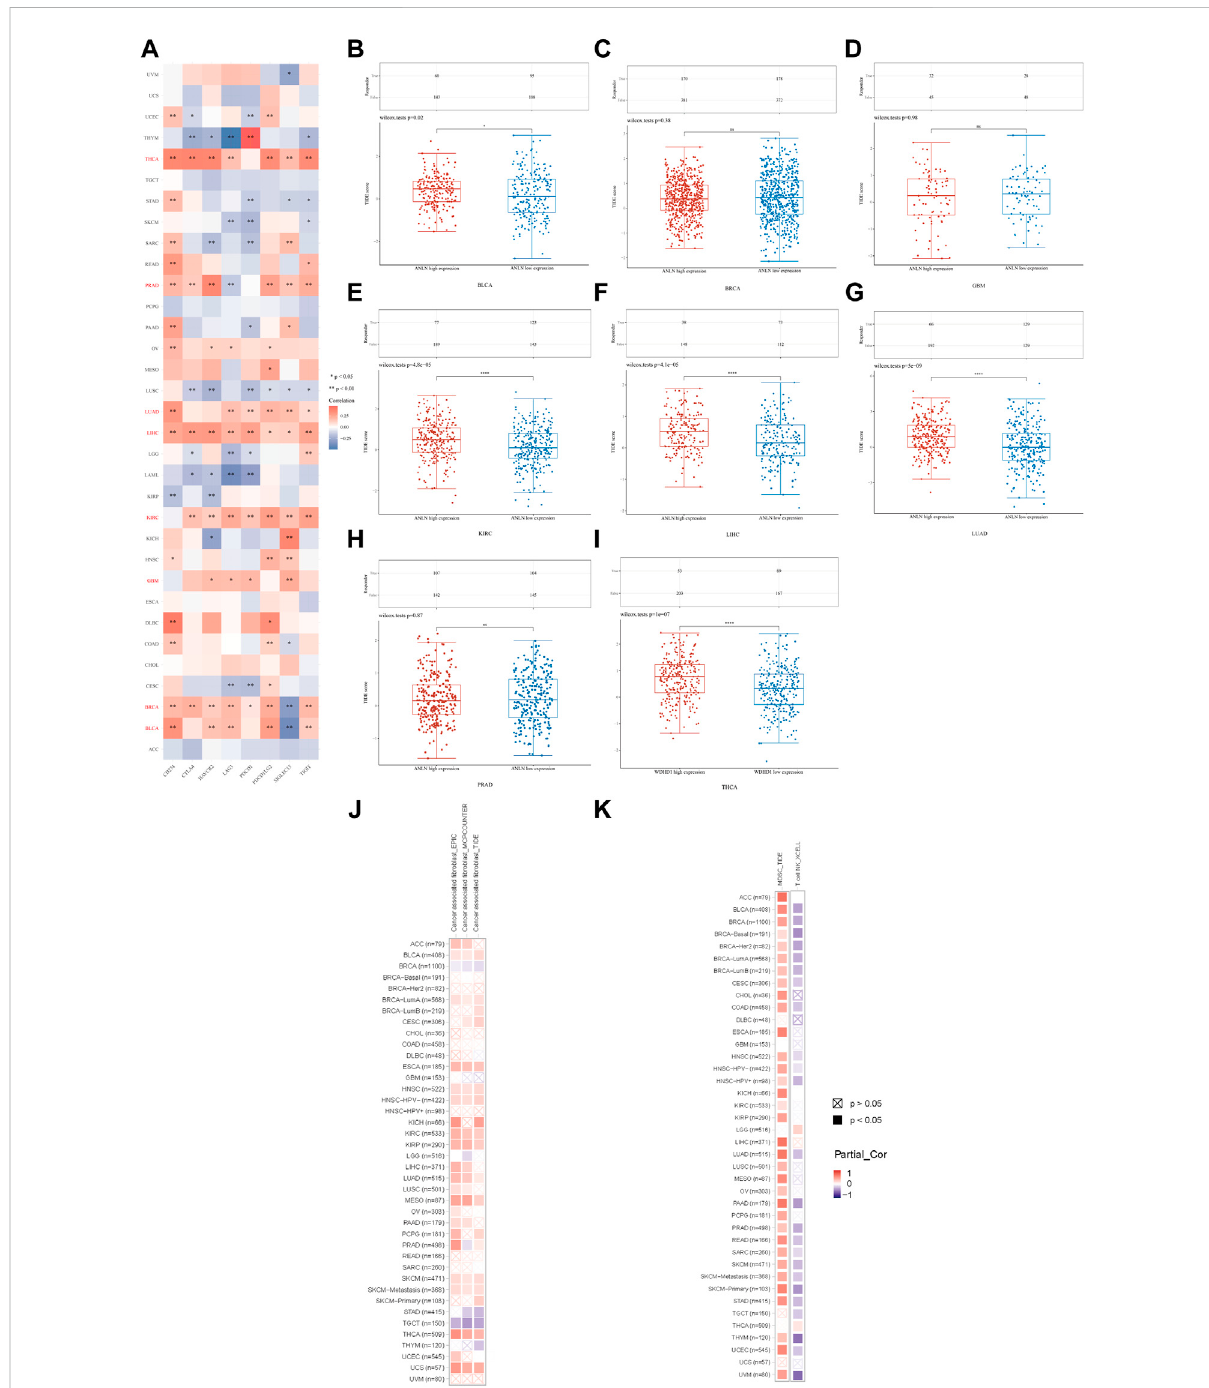
FIGURE 10 (A) CorrelationbetweenANLNandimmunoinhibitorsinpan-cancer.TIDEscoreofANLNhighandlowexpressiongroupsinBLCA (B) ,BRCA (C)